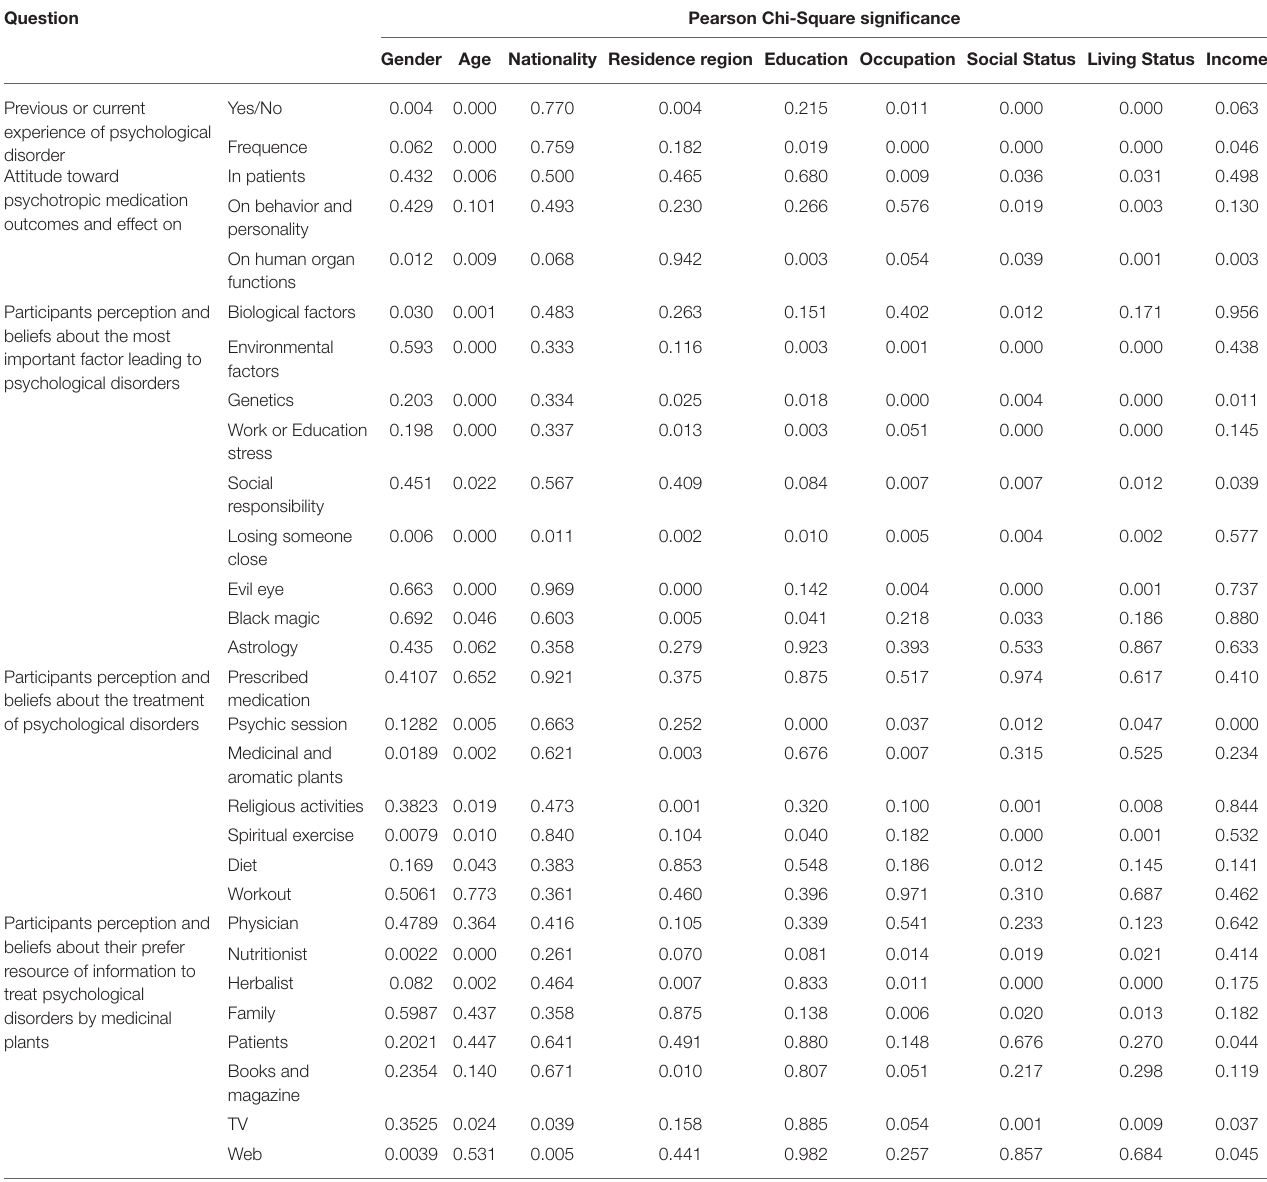
TABLE 7 | Cross tabulation between participants’ socio-demographic parameters and different survey question.